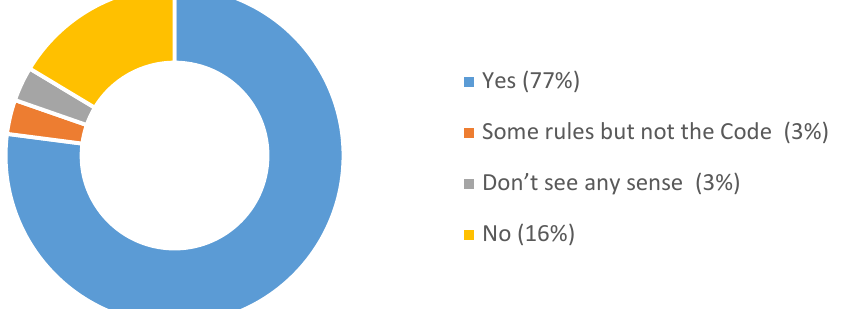
Figure 3. Structural indicators of answers to questions that determine the urgency of the research